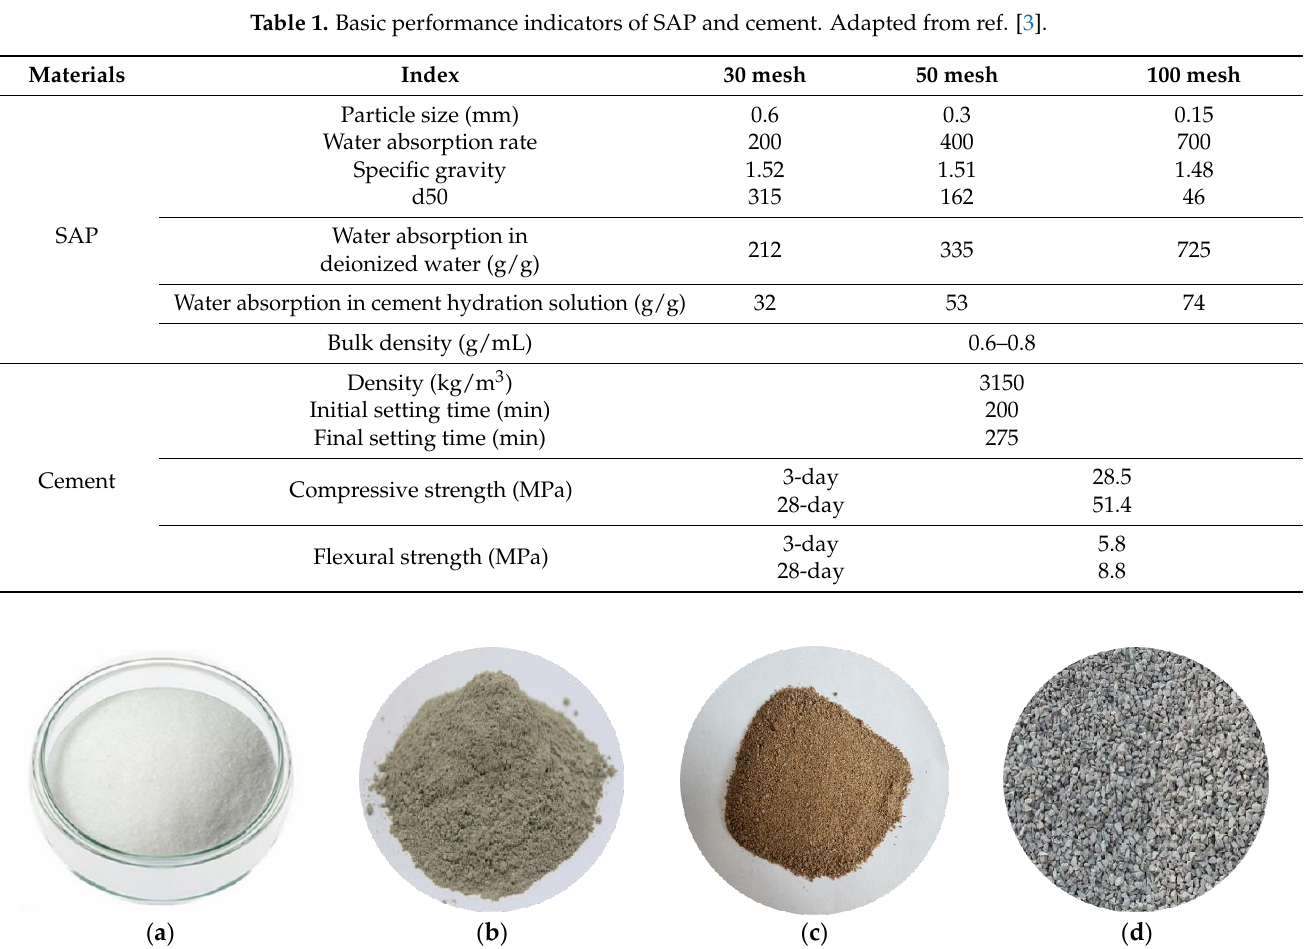
Figure 1. Test materials: ( a ) SAP; ( b ) cement; ( c ) fine aggregate; ( d ) coarse aggregate. Table 1. Basic performance indicators of SAP and cement. Adapted from ref. [3].